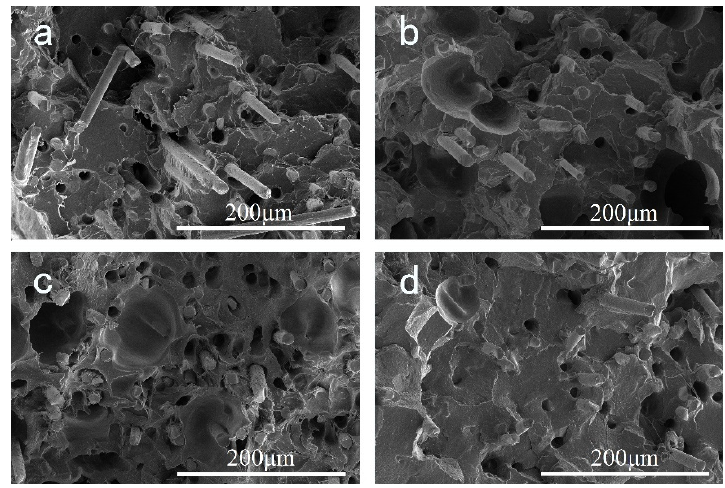
Figure 8. SEM images of cryo-fractured surfaces of different 3D printing filaments: ( a ) S-1; ( b ) S-2; ( c ) S-3; ( d ) S-4. The magnification is 1000.